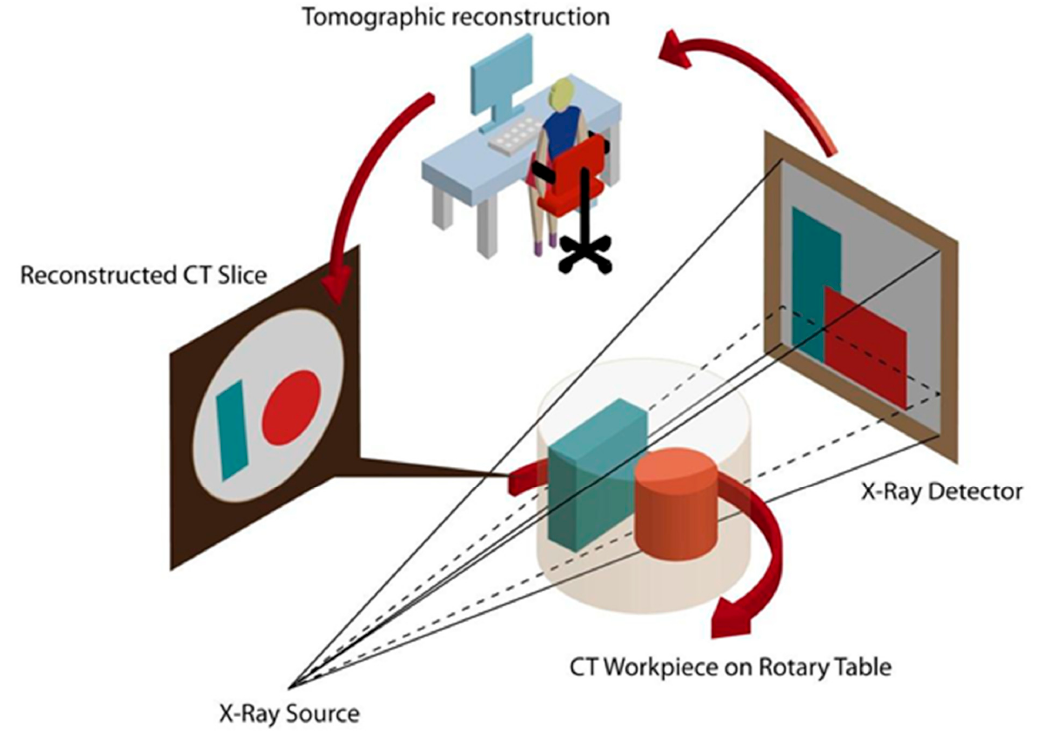
Figure 1. Generic X-ray computed tomography (CT) process with cone-beam geometry. Reproduced, with permission, from Reference [3].